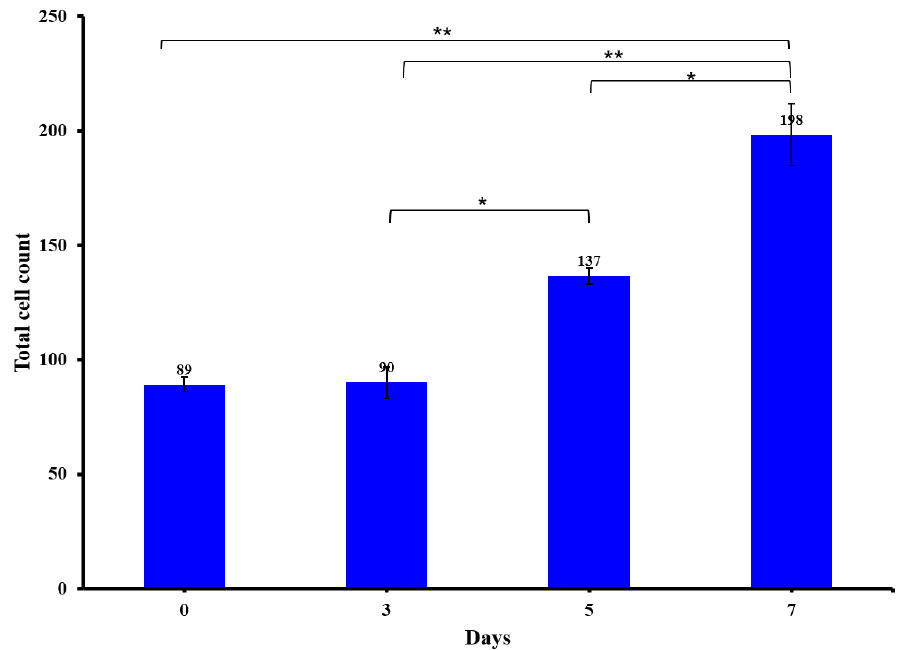
Figure 7. Total cell counts from maximum intensity project of the bioprinted CH–GE–PEG cell-laden constructs throughout seven days ( n = 3, ±SD). Differences between experimental data at * = p < 0.05; ** = p ≤ 0.01 were considered as statistically significant.